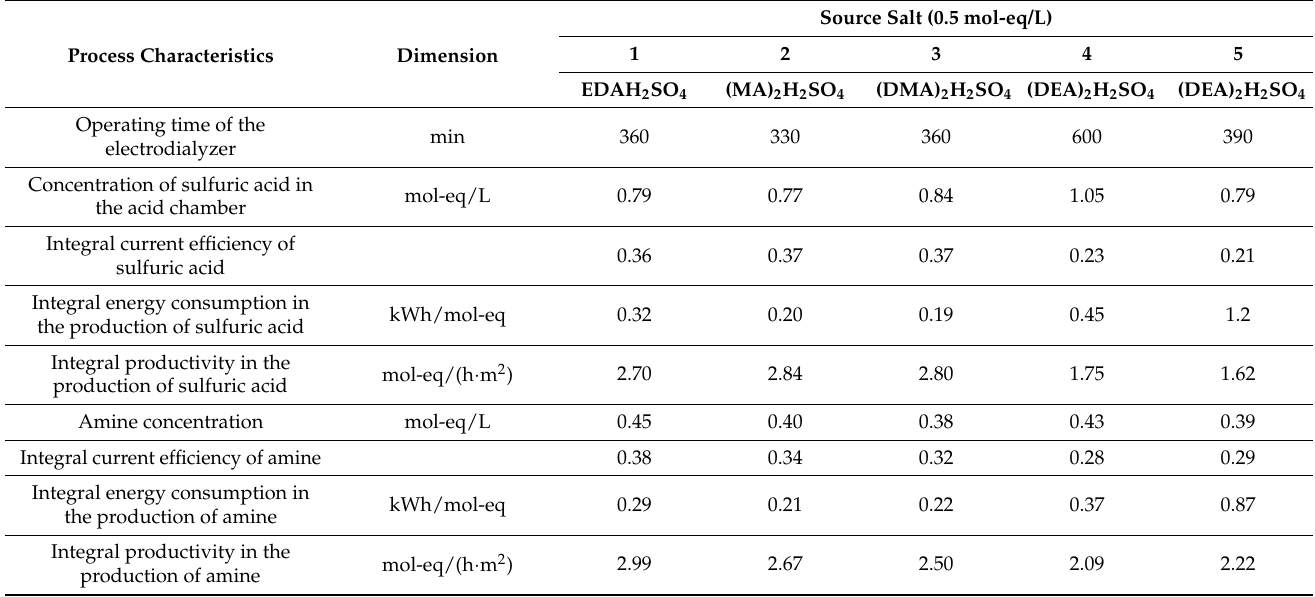
Table 1. Characteristics of electrodialysis processes using modified bipolar membrane aMB-2m and anion-exchange membranes Ralex AMH (1–4) and MA-40L (5) at a DC density equal to 2 A/dm 2